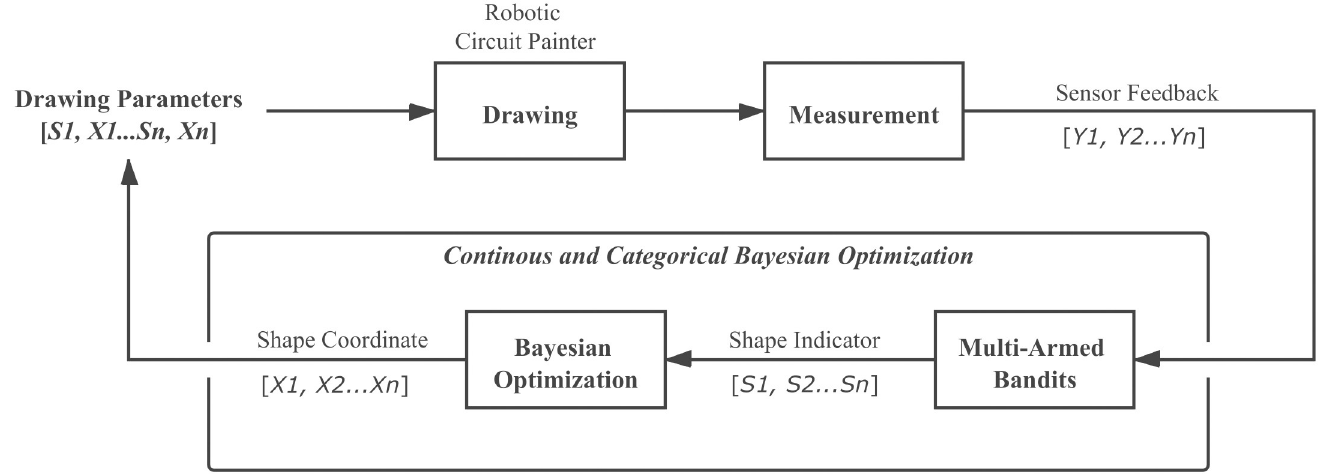
Fig 4. Continuous and categorical Bayesian optimization. The continuous and categorical Bayesian optimization approach we investigate in this paper for circuit optimization.